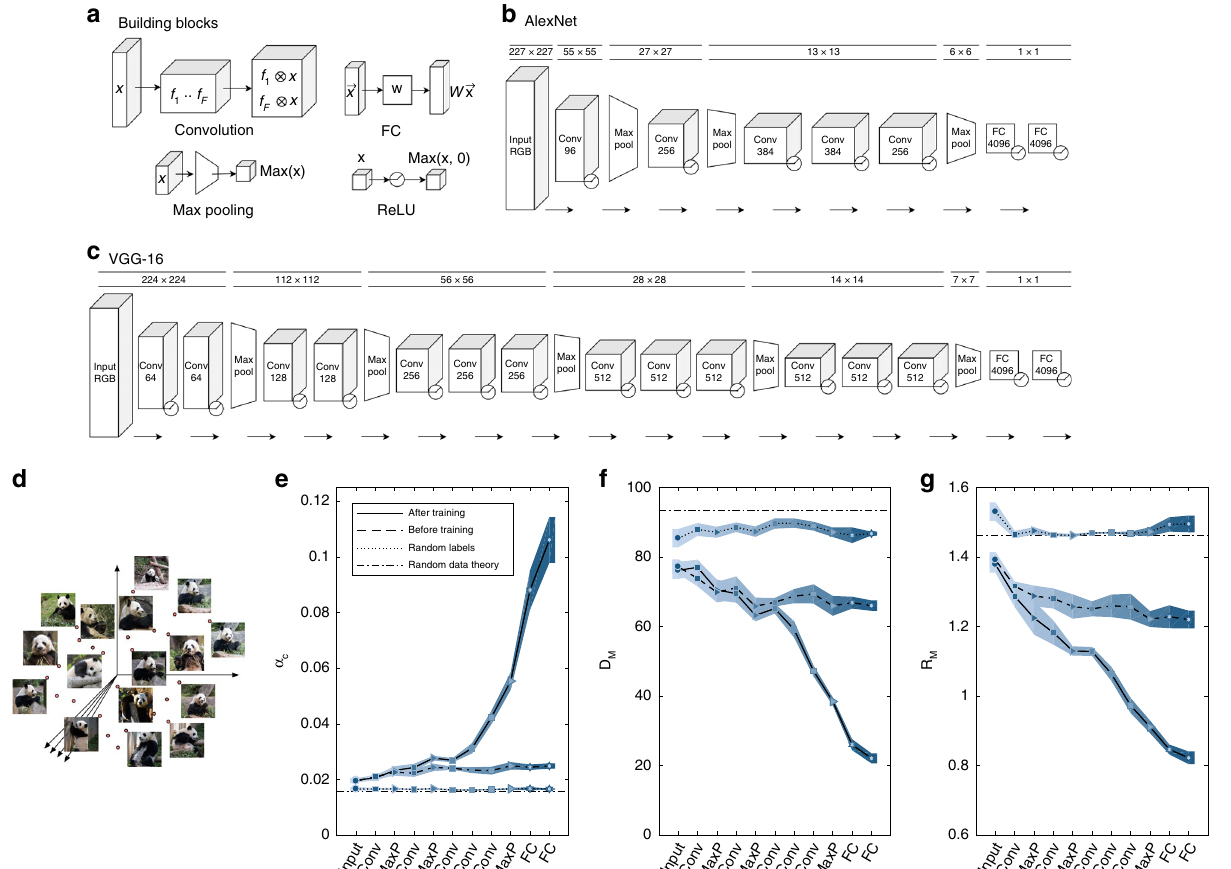
Fig. 3 Manifolds capacity and geometry changes during learning. a Illustration of computational building blocks used in AlexNet and VGG-16. Convolution: a set of linear 2-d fi lters applied on a spacial set of features, each producing a new spacial map. FC: linear fully connected operation (matrix multiplication). Max pooling: a local nonlinearity calculating the maximal activation at small overlapping patches. ReLU: point-wise nonlinearity which sets negative input value to zero. Detailed description of b AlexNet and c VGG-16 structure, composed of the above building blocks. Dimensions on top describe the spacial dimensions of the layer; the dimension of Conv layers describe the number of convolution fi lters while the dimension of FC layers is the number of output neurons. ReLU nonlinearity is shown following other operations and is not counted as a layer. d Illustration of a point-cloud manifold for the ‘ giant panda ’ class, in high-dimensional state space. e – g Changes in capacity and manifold geometry along the layers of AlexNet point-cloud manifolds (top 10%) for fully trained network (full line), randomly initialized network (dashed line) or randomly shuf fl ed object manifolds (dotted line). Line and markers indicate mean value over fi ve different choices of 50 objects; surrounding shaded areas indicate 95% con fi dence interval. The value expected by theory for random points (see Methods) is shown as dash-dot line. e Changes in classi fi cation capacity. f Changes in mean manifold dimension. g Changes in mean manifold radii. Classi fi cation capacity, manifolds dimensions and radii were measured using mean- fi eld theory (see Methods). The x -axis labels provides abbreviation of the layer types (Input — pixel layer, Conv — convolutional layer, MaxP — max-pooling layer, FC — fully connected layer). Marker shape represents layer type (circle — pixel layer, square — convolution layer, right-triangle — max-pooling layer, hexagon — fully connected layer). Features in linear layers (Conv, FC) are extracted after a ReLU